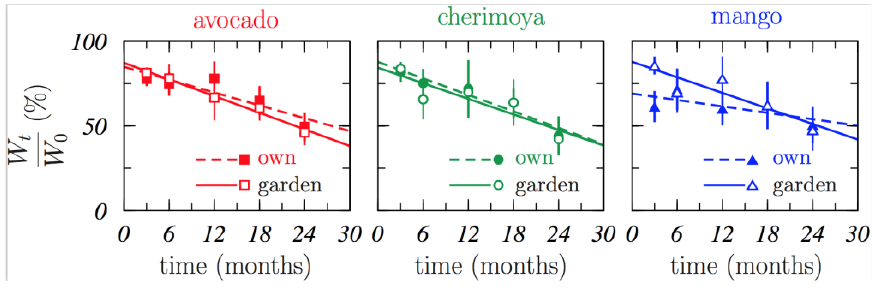
Figure 2. Weight loss from pruning waste of the subtropical species (avocado, cherimoya, and mango) and garden waste under the three trees for each sampling period expressed as percentages of W t / W 0 . W t — dry weight (g) after time t (months); W 0 — initial dry weight (g).